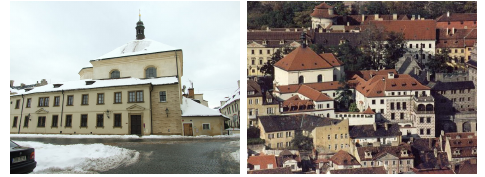
Figure 1. Carmel Monastery in the Prague Castle Square, view to the southern terrace of monastery.